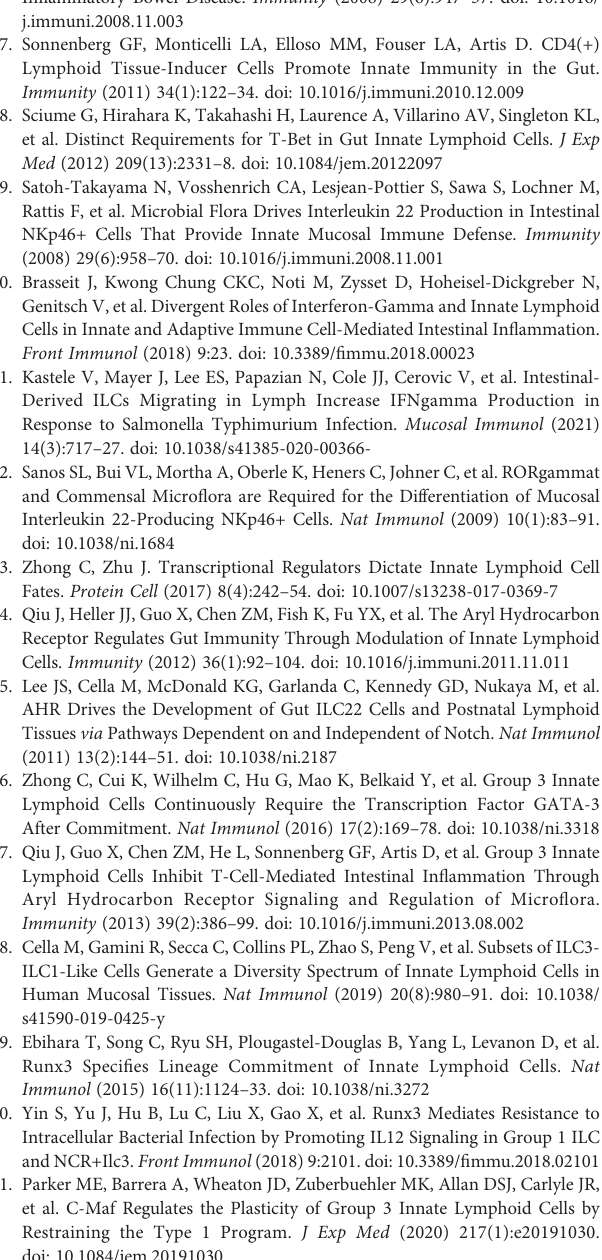
trajectoryanalysis. (D) TheVolcanoplotofupregulatedanddownregulatedgenesin WT and ThPOK-de fi cient ILC3s of the RNA-seq data set. (E) KEGG pathway enrichment analysis performed by using DAVID. The top 15 highly enriched KEGG pathways are presented. KEGG, Kyoto Encyclopedia of Genes and Genomes database; DAVID, Database for Annotation, Visualization and Integrated Discovery. (F) Violin plots showing differential expression of several ILC3 key genes. (G) Overlaid histograms (upper) show expression of indicated protein in ThPOK- de fi cient mice(red), control mice (yellow) and Isotype (grey). Graphs (lower) show MFI of protein expression. (H) Mean fl uorescence intensity (MFI) of the indicated proteins in ILC3s. (mean ± SEM; n = 5-8; Student ’ s t test). Data are representative of at least three independent